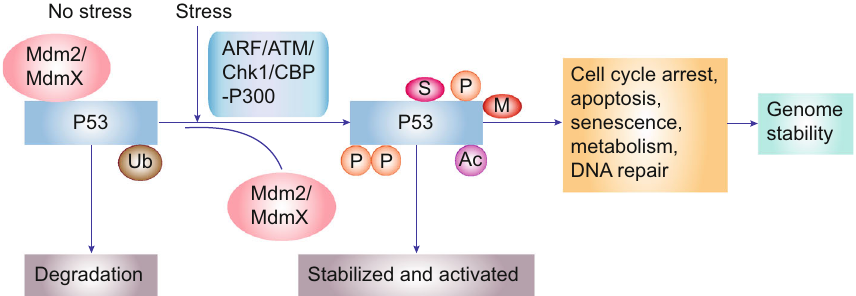
Figure 1. The roles of p53 in somatic cells. In the absence of stress, p53 is inactive and unstable due to its interaction with its transcriptional targets Mdm2/MdmX. In response to stresses, various posttranslational modi fi cations of p53 can stabilize and activate p53 by disrupting the interaction between p53 and Mdm2/MdmX, leading to cell cycle arrest, apoptosis, senescence, DNA repair and